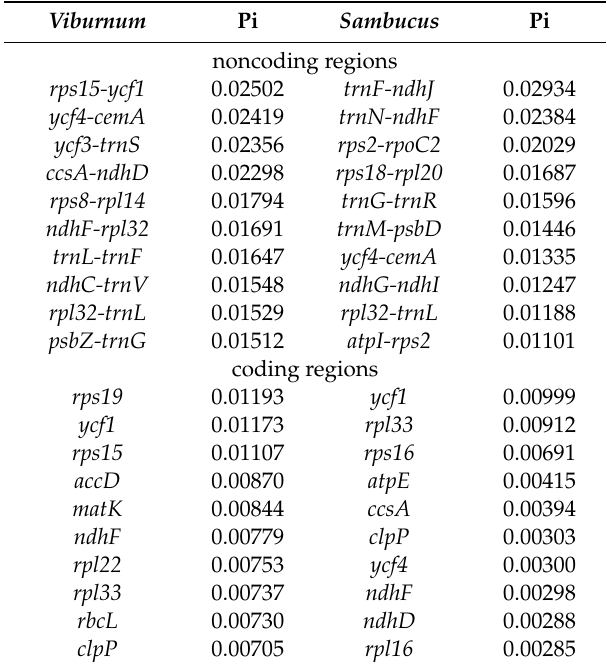
Table 3. Pi values of the ten most variable coding and noncoding regions in Viburnum and Sambucus